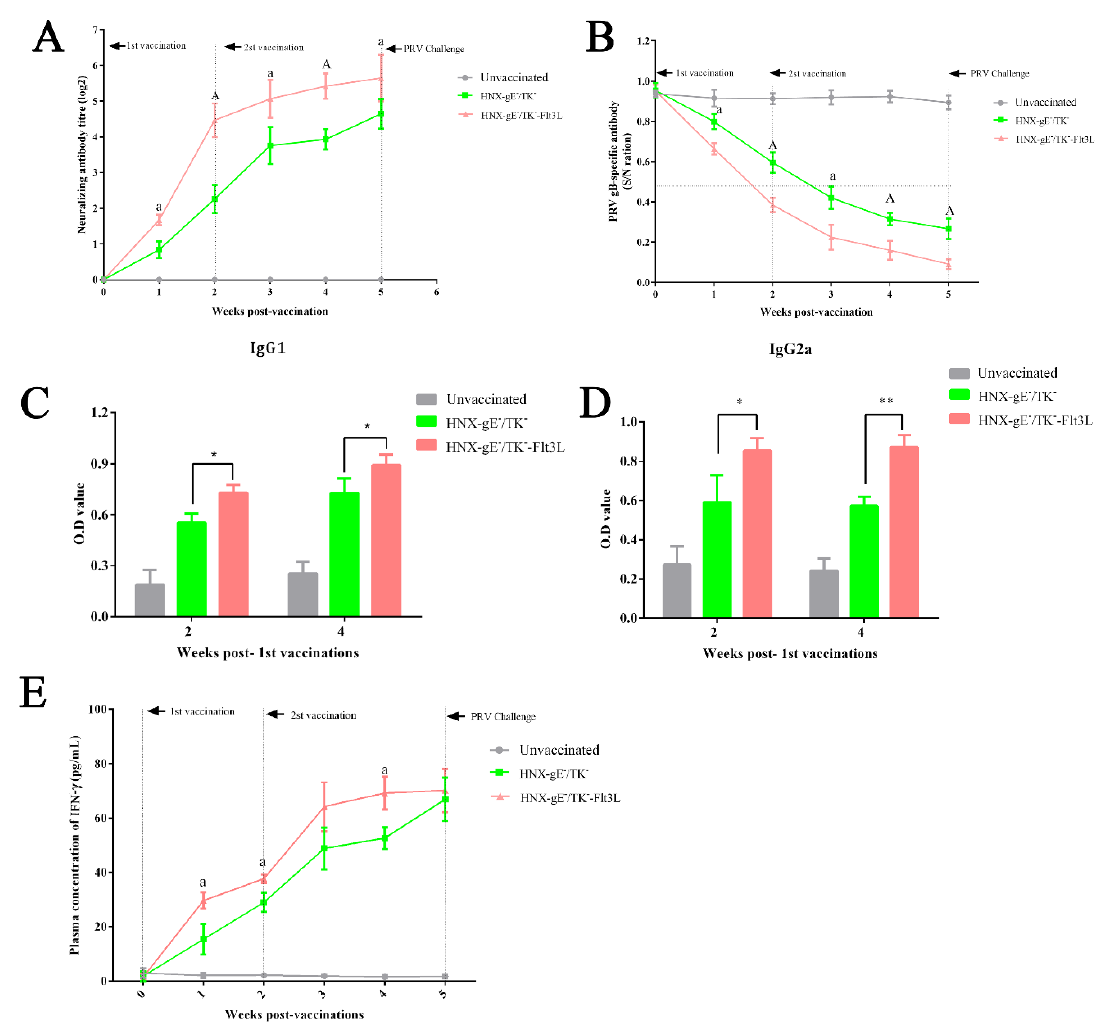
Figure 6. Immune responses after immunization with HNX-TK − /gE − -Flt3L in mice. Three groups of mice were intramus- cularly injected with HNX-TK − /gE − , HNX-TK − /gE − -Flt3L or DMEM. ( A ) The neutralizing ability of antisera generated against HNX strain was calculated and expressed as the log. ( B ) gB-specific antibody ELISA. ( C , D ) The PRV-specific IgG1 and IgG2a titers were detected at two or four weeks post the first immunization through ELISA. ( E ) Cytokine IFN-γ ELISA. The data are the means from three independent experiments. *, p < 0.05; **, p < 0.01. a, p < 0.05; and A, p < 0.01. Note, the superscripts (a or A) in the picture indicated the differences between HNX-TK − /gE − -Flt3L vaccinated group with HNX- TK − /gE − vaccinated group.